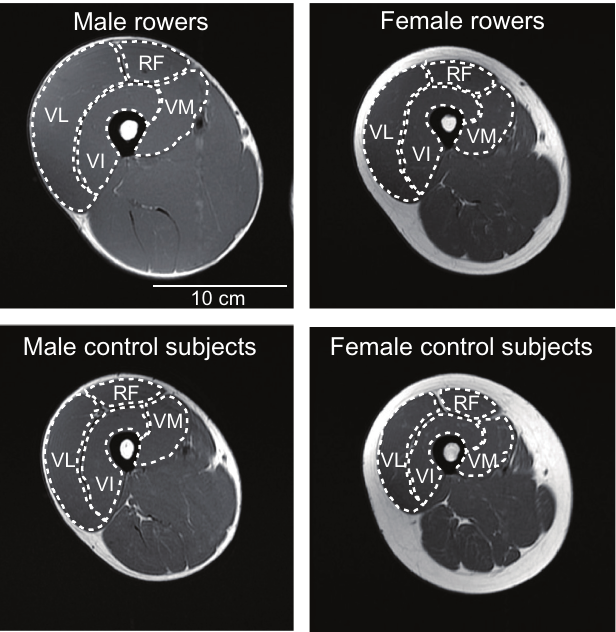
vastus intermedius;RF, rectus